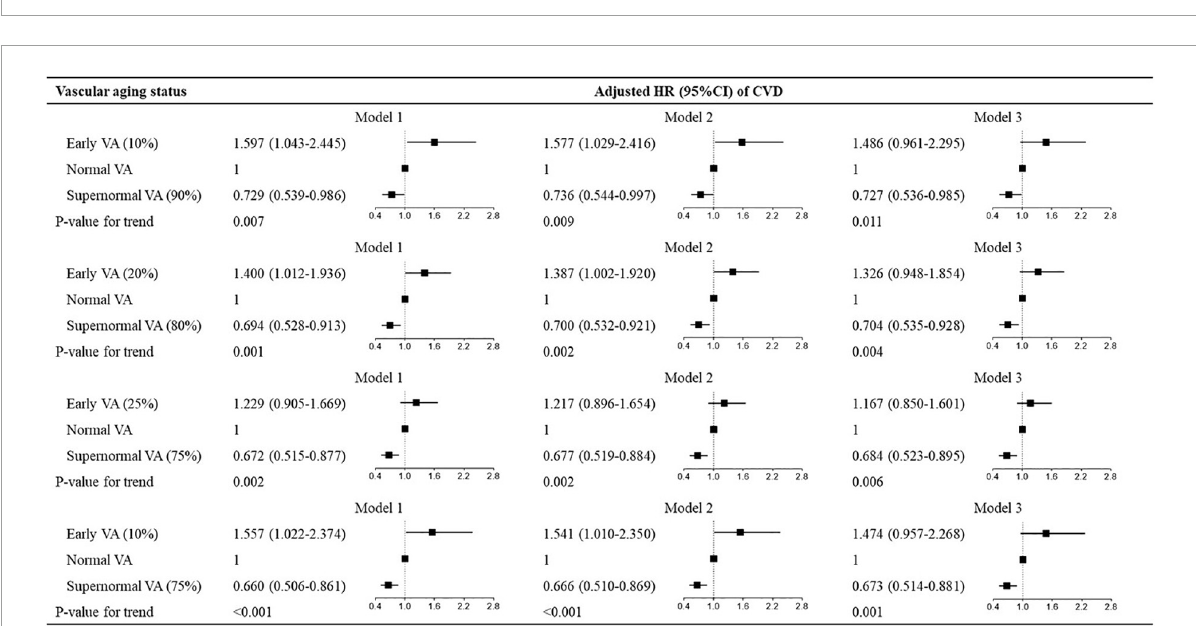
FIGURE2 Hazard ratios for VA categories for CVD in sex subgroups. Model 1: adjusted for age and sex; model 2: model 1 + Framingham risk score; model 3: model 1 + ASCVD risk score. VA, vascular aging; CVD, cardiovascular disease; ASCVD, atherosclerotic cardiovascular disease; HR, hazard ratio; CI, confidence interval.